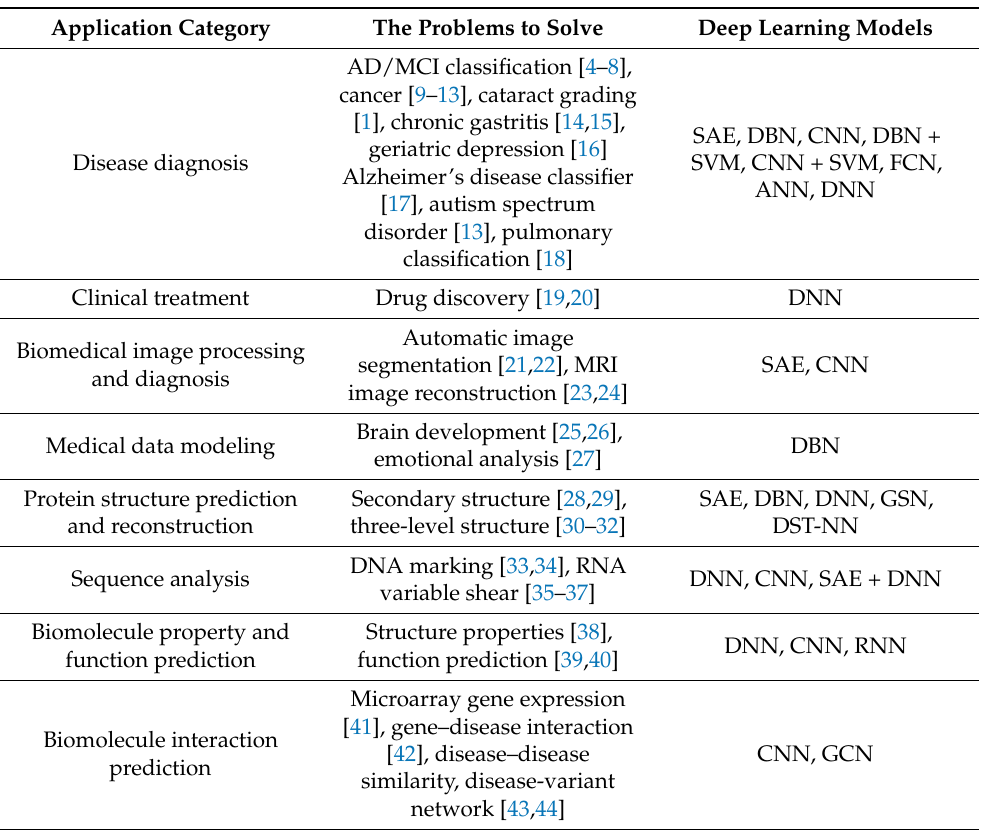
Table 1. Medical applications based on deep